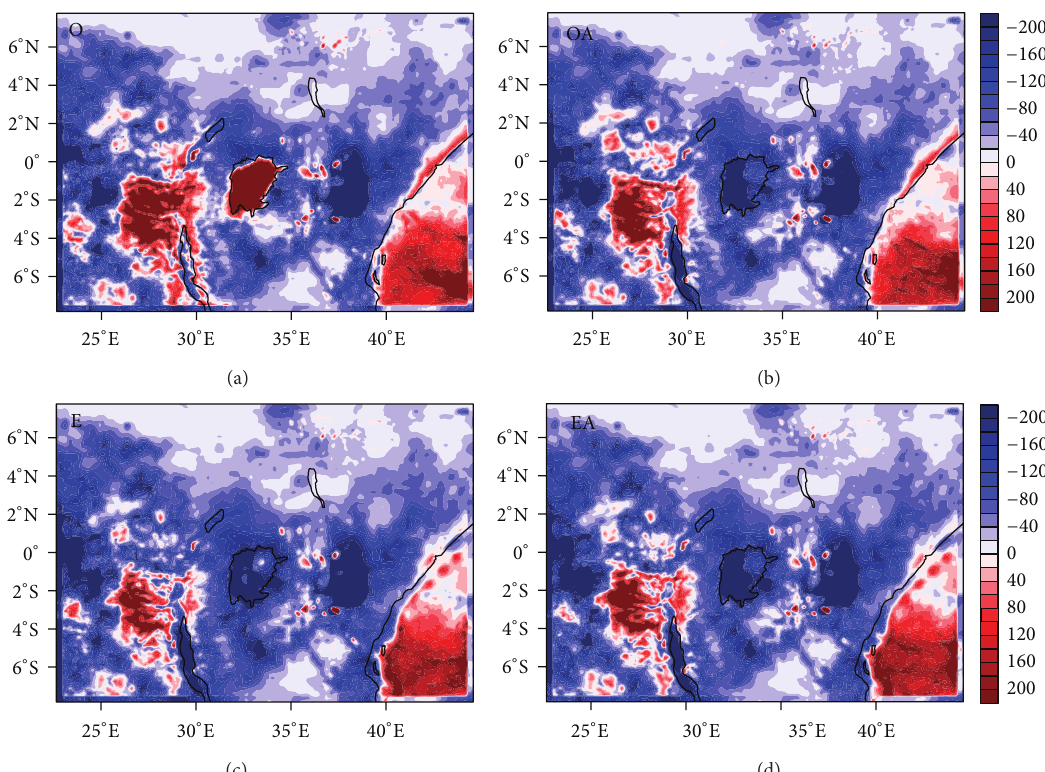
Figure 6: November difference (in mm) between TRMM data and WRF model output over domain